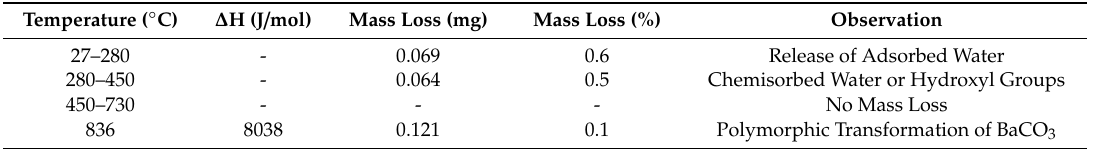
Table 2. Heat flow and mass loss for BSTCo5.